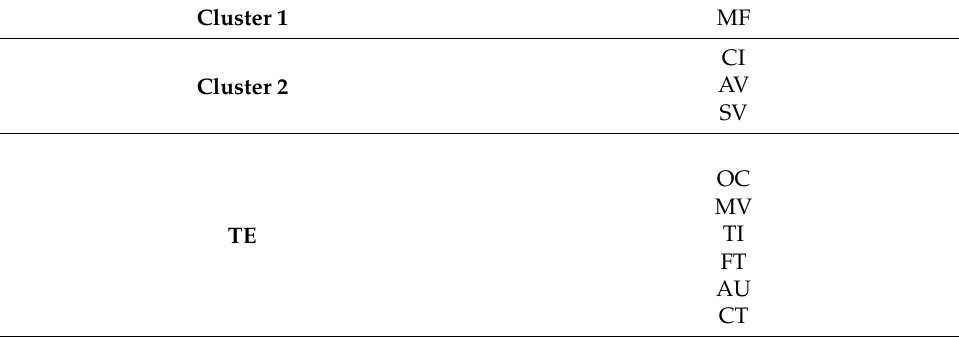
Table A1. Cluster label of each complexity indicator.